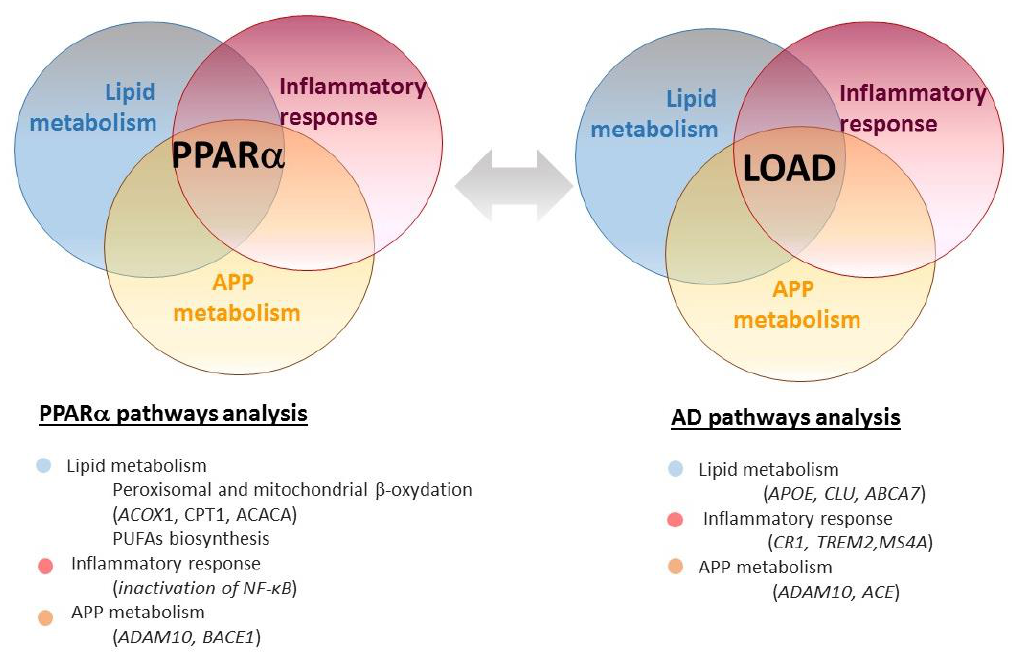
Figure 2. Common pathways regulated by proliferator-activated receptor α (PPARα) and involved in the etiology of AD. Peroxisome proliferator-activated receptor α (PPARα) is a transcription factor that governs pathways involved in the metabolism of lipids, inflammatory response and the metabolism of the amyloid precursor protein (APP), which have been implicated in the etiology of late-onset Alzheimer’s disease (LOAD). Genome-wide association studies identified several genetic risk factors for LOAD, which are involved in pathways that are governed by PPARα. Abbreviations: ABCA7 (ATP-binding cassette subfamily A member 7), ACE (Angiotensin-converting enzyme gene), APOE